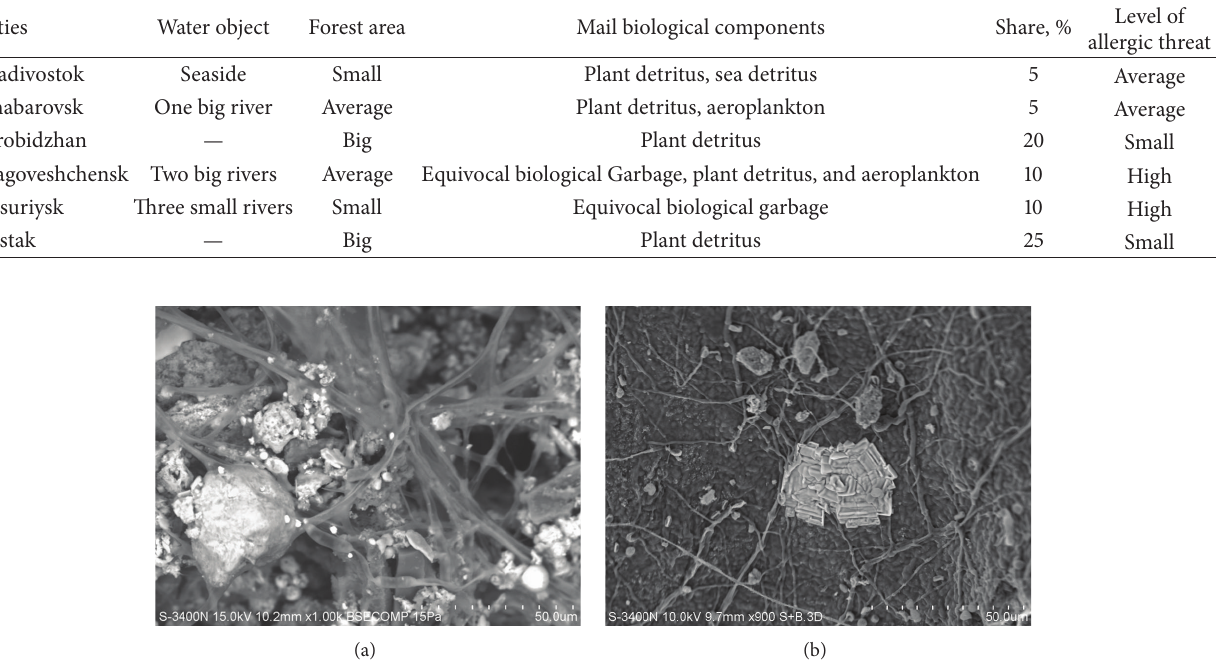
Figure 4: Hyphae of fungi from a snow sample taken: (a) at the Pervomayskiy park area in Blagoveshchensk, (b) at the Child Sanatorium